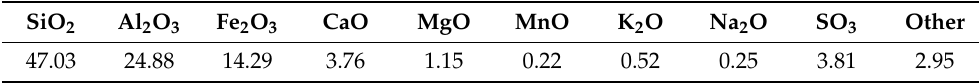
Table 4. Coal ash analysis (in